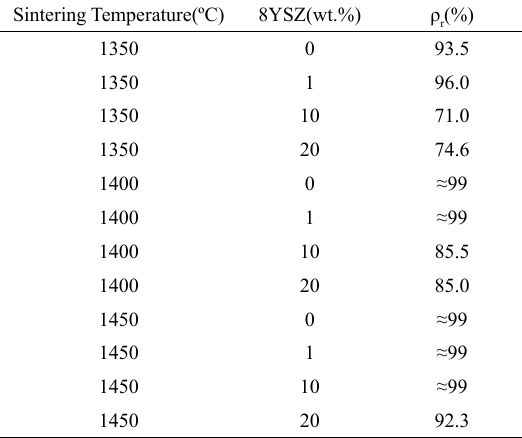
) for LSGM pellets containing Table 1. Values of relative density (ρ (c) LSGM+10 wt.% 8YSZ, and (d) LSGM+20 wt.% r different amounts of 8YSZ and sintered at several temperatures for 4 h. Sintering Temperature(ºC)